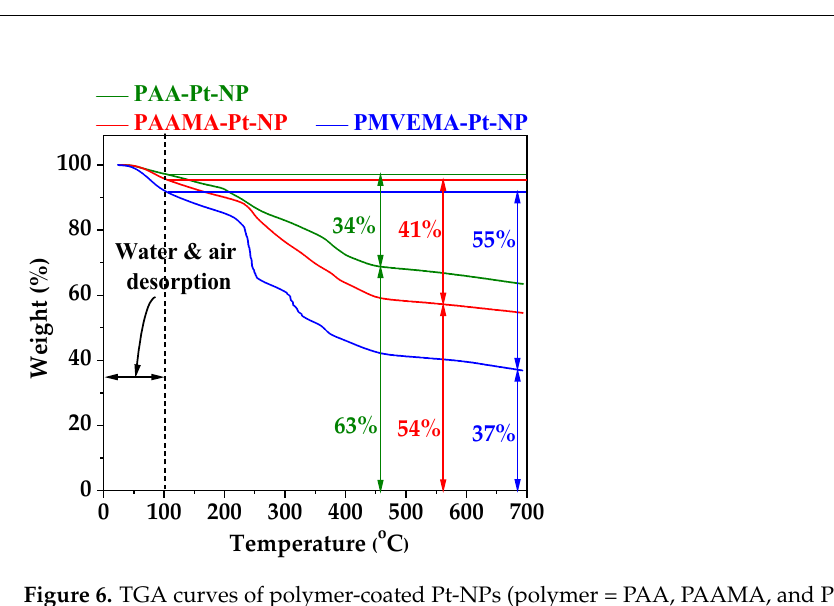
Figure 6. TGA curves of polymer-coated Pt-NPs (polymer = PAA, PAAMA, and PMVEMA). Table 3. Summary of the surface-coating amount.